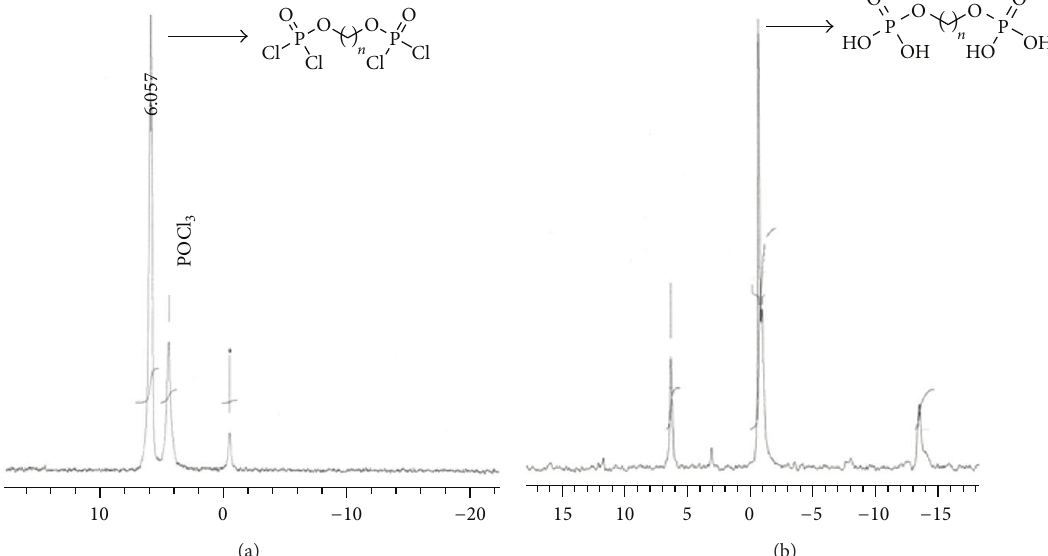
Figure 1: 31 P NMR spectra of the reaction mixtures, obtained during the two-step synthesis. (a) Step 1 , (b) step 2 (Method 1